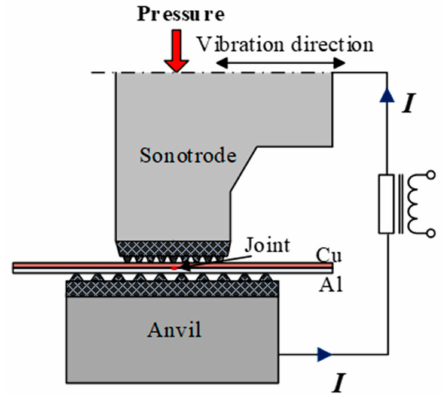
Figure 1. The principle of resistance heat-assisted high-power ultrasonic welding